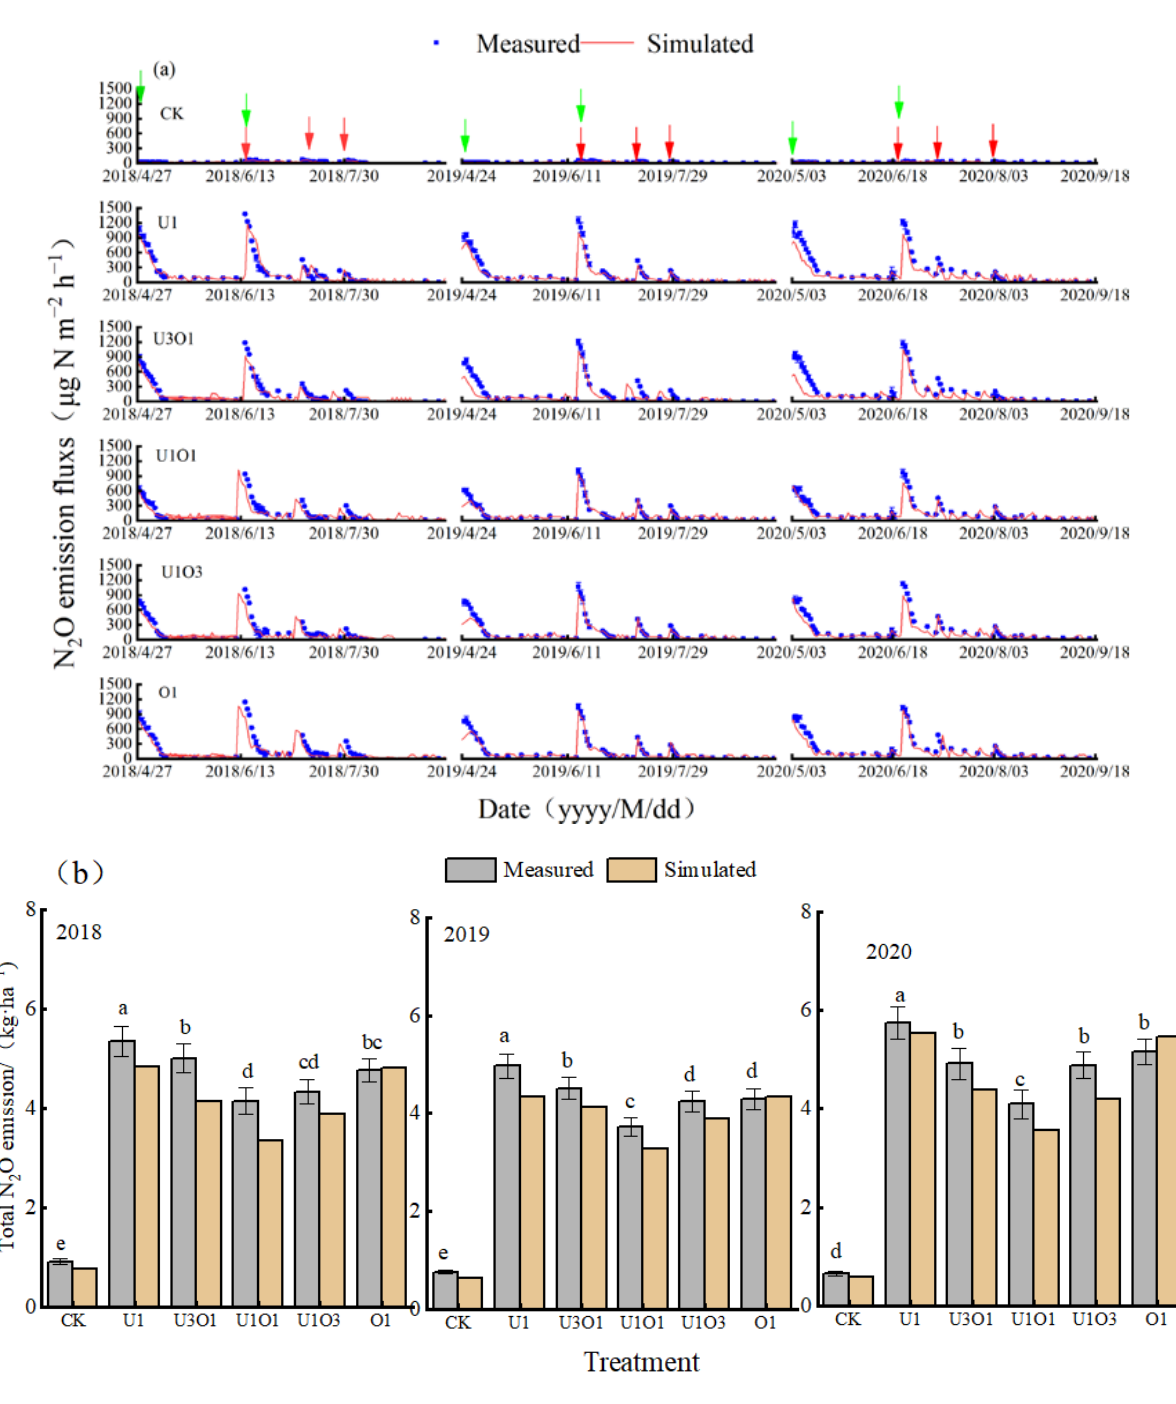
Figure 5. Simulated and measured values of soil N 2 O emission rate ( a ) and total emissions ( b ). Note: green and red arrows indicate fertilization and irrigation events, respectively. The measured data are the means of three replicates, and vertical bars indicate standard errors of the replicates. Different small letters indicate significant differences ( p < 0.05) between